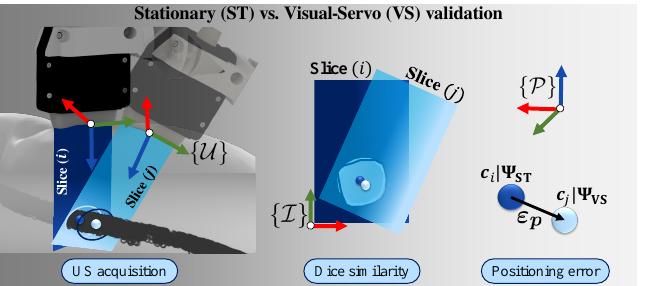
troids ( Ψ US ) at a mean positioning error of 1.9 correspondence of the reconstructed US artery with the ground truth (Figure 6).